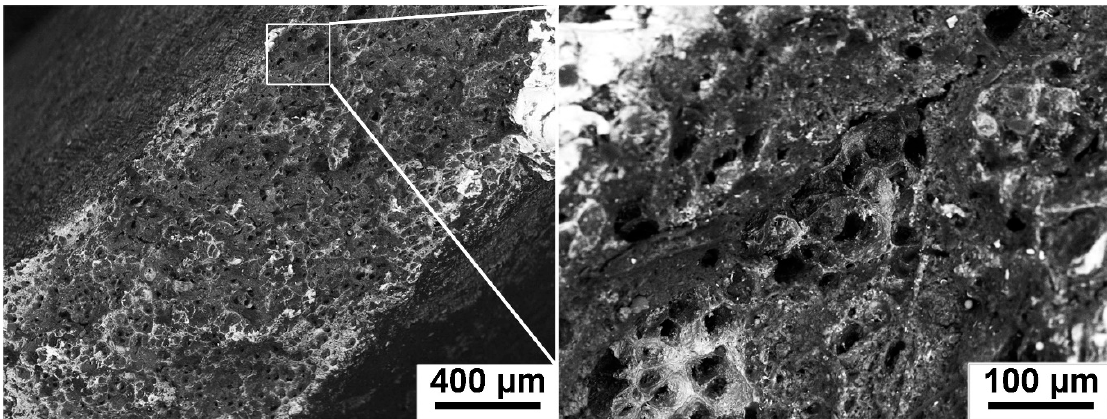
Figure 11. Fracture surface of the specimens of the 9Cr1.5W0.012 B steel tested at the applied stress of 120 MPa.